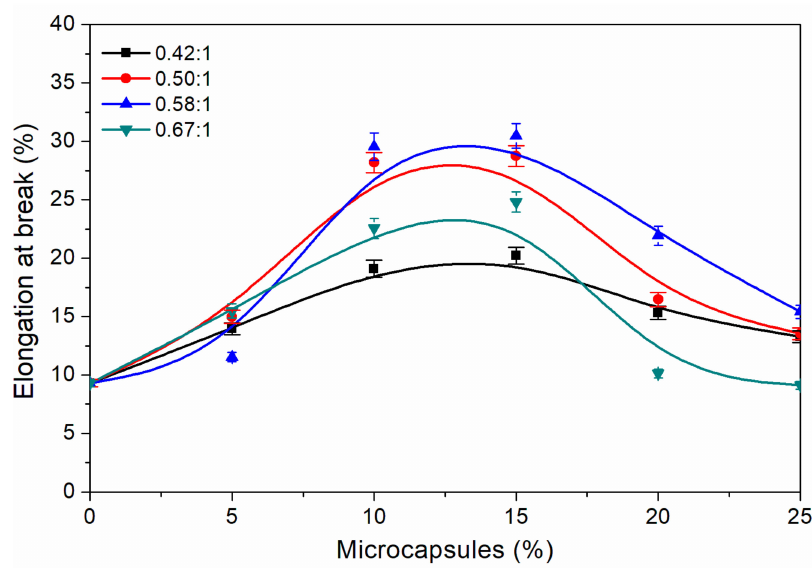
Figure 9. E ff ect of the concentration of microcapsules with di ff erent core–wall ratios on the elongation at break of waterborne primer coating.